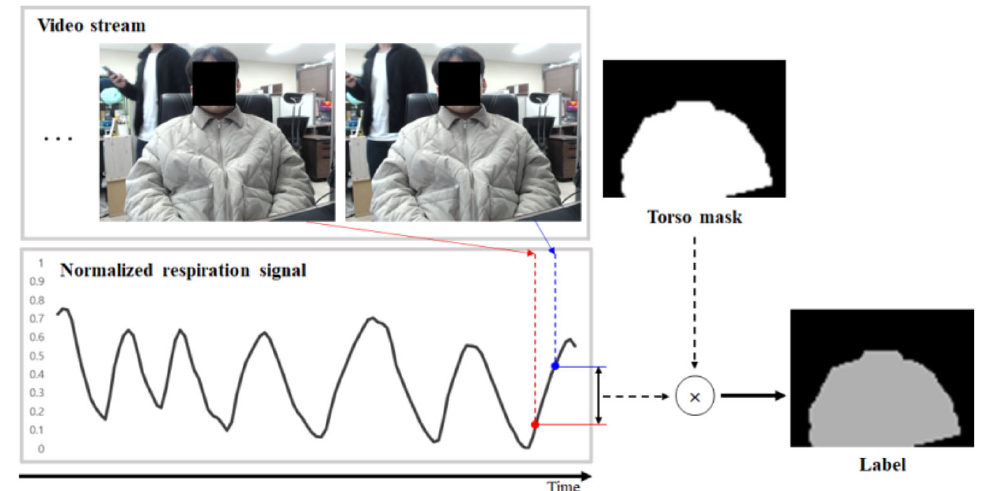
Figure 6. Constructing a training dataset construction from video and respiration signals with a contact sensor.